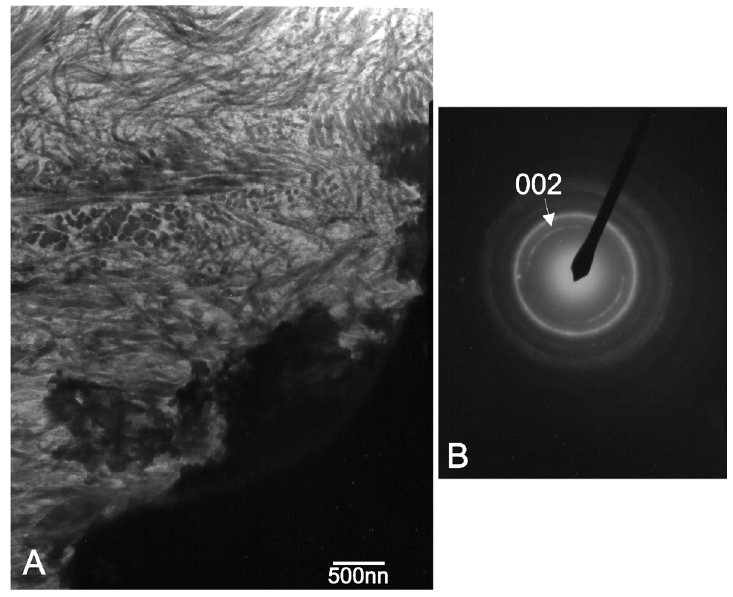
Figure 10. ( A ) Transmission electron micrograph of the stained interface at the 15th month, showing well resolved collagen fibers in the new formed Ca-P phase; ( B ) Equivalent selected area diffraction pattern of the new bone tissue; unstained thin